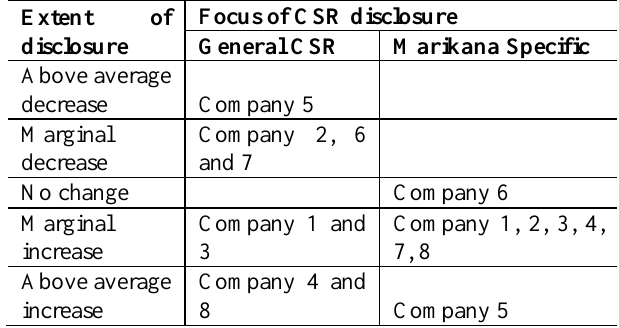
Table 3: Analysis of disclosure